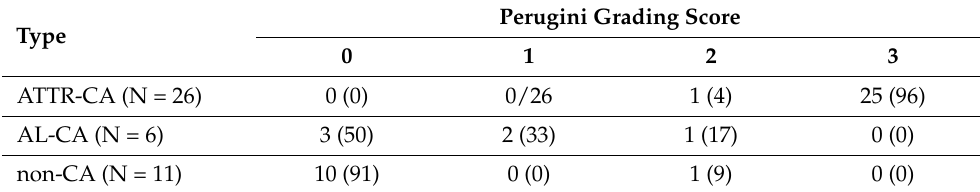
Table 1. Cardiac uptake of 99m Tc-PYP.